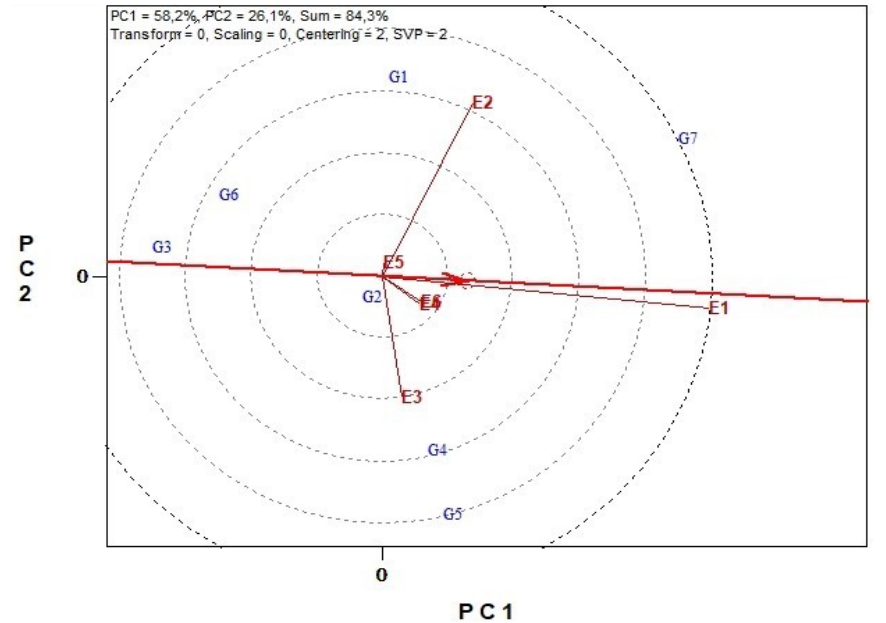
Figure 3. “Discriminating power vs. representativeness” view of the GGE biplot based on biomass yield on 7 V. sativa genotypes in six environments. Environment 4 and Environment 6 coincide.